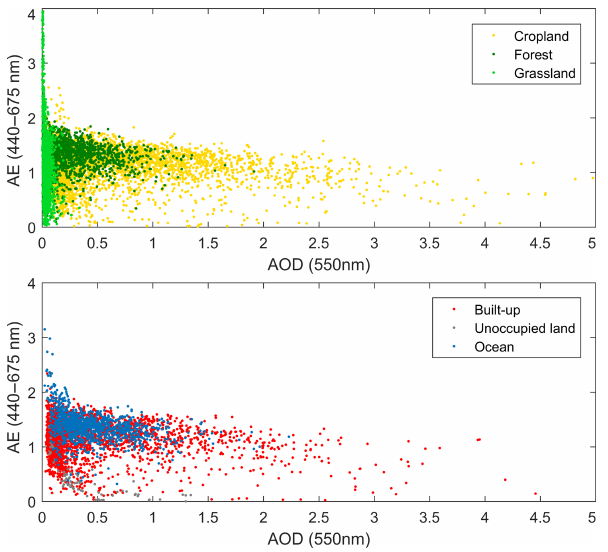
Figure 6. Scatterplot of AOD at 550nm against the Ångström ex- ponent for different land cover types. We selected AERONET sites with maximum observations for each land cover type: XiangHe (cropland); Taipei_CWB (forest); QOMS_CAS (grassland); Bei- jing (built-up); Dunhuang (unoccupied land); Hong_Kong_PolyU